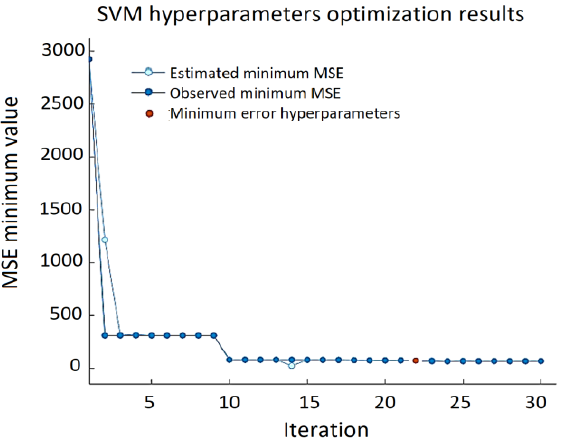
Figure 10. Minimum MSE during SVM hypermeters’ optimization process.